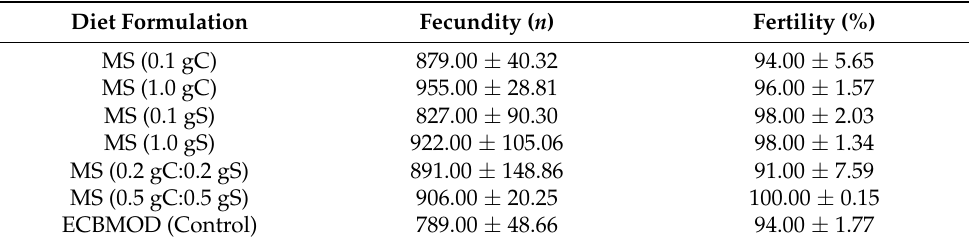
Table 9. Mean ( ± SE) fecundity of Eldana saccharina female moths [ n = 15] and their egg fertility after mating with moths from the same formulations, from the MS (0.1 gC), MS (1.0 gC), MS (0.1 gS),